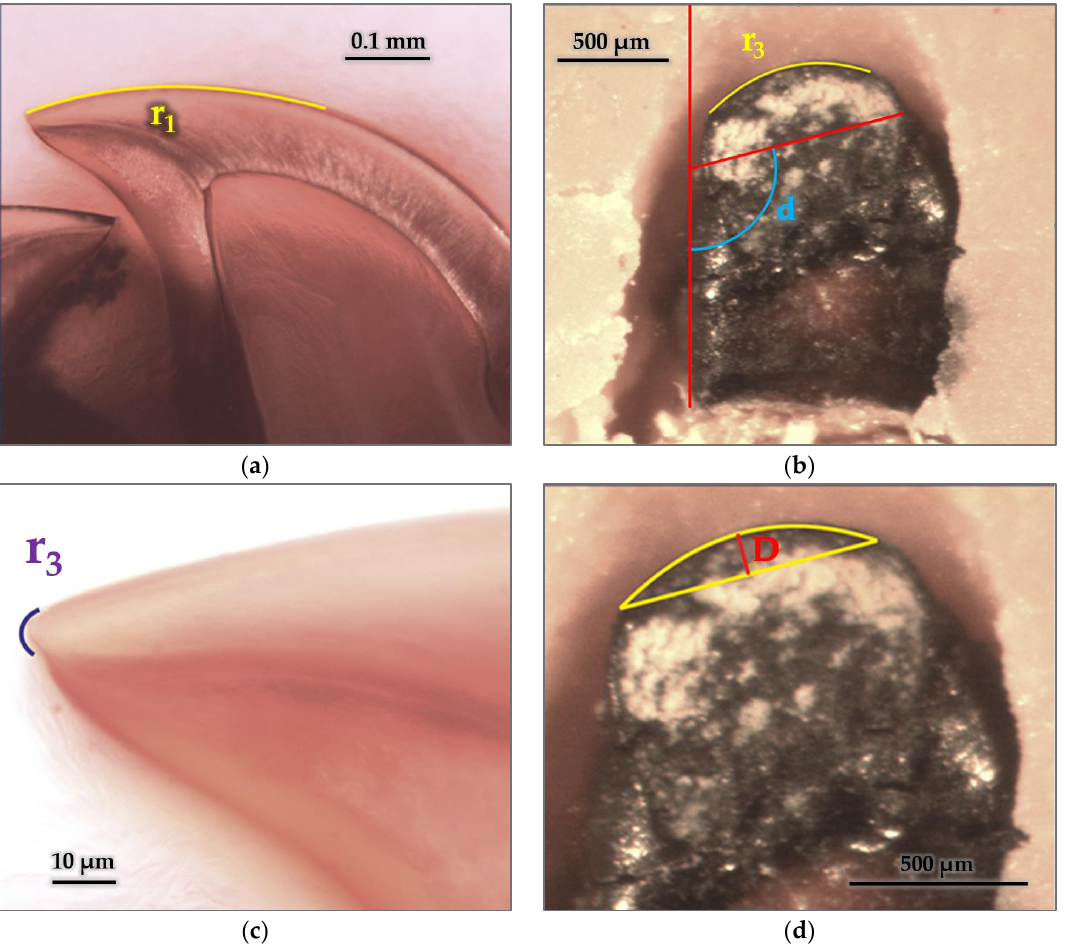
Figure 12. The radius and arches of the mandibles: ( a ) Radius of curvature of the flank r1 = 566 μm ; ( b ) radius of the arc of the cutting edge r2 = 574 μm ; ( c ) edge radius r3 = 3 μm ; ( d ) angle of the tangent to the cutting arc with the longitudinal axis of the jaw d = 106.5°; ( d ) maximum cut depth of the insect bite D = 120 μm.